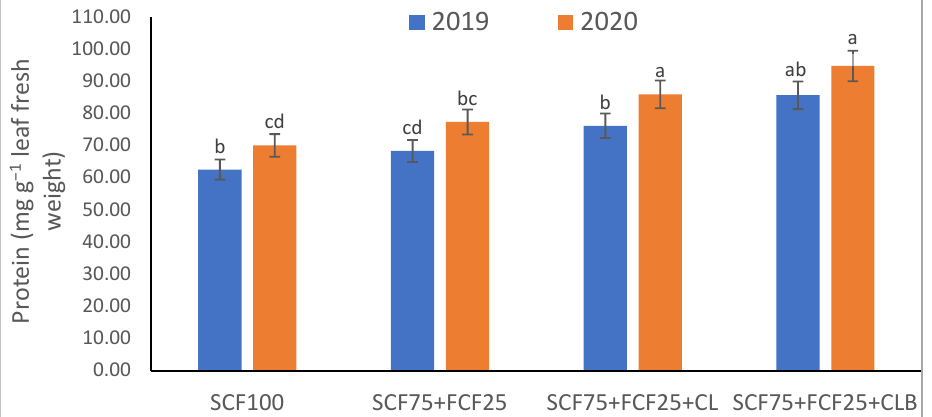
Figure 12. Response of leaf enzyme activity (protein) of Phaseolus vulgaris plants to different fertilization strategies applied in two seasons (2019 and 2020) to sandy soil. Abbreviations of fertilization treatments are explained in Table 1. Bars with a different letter indicate significant difference between treatments at p ≤ 0.05.